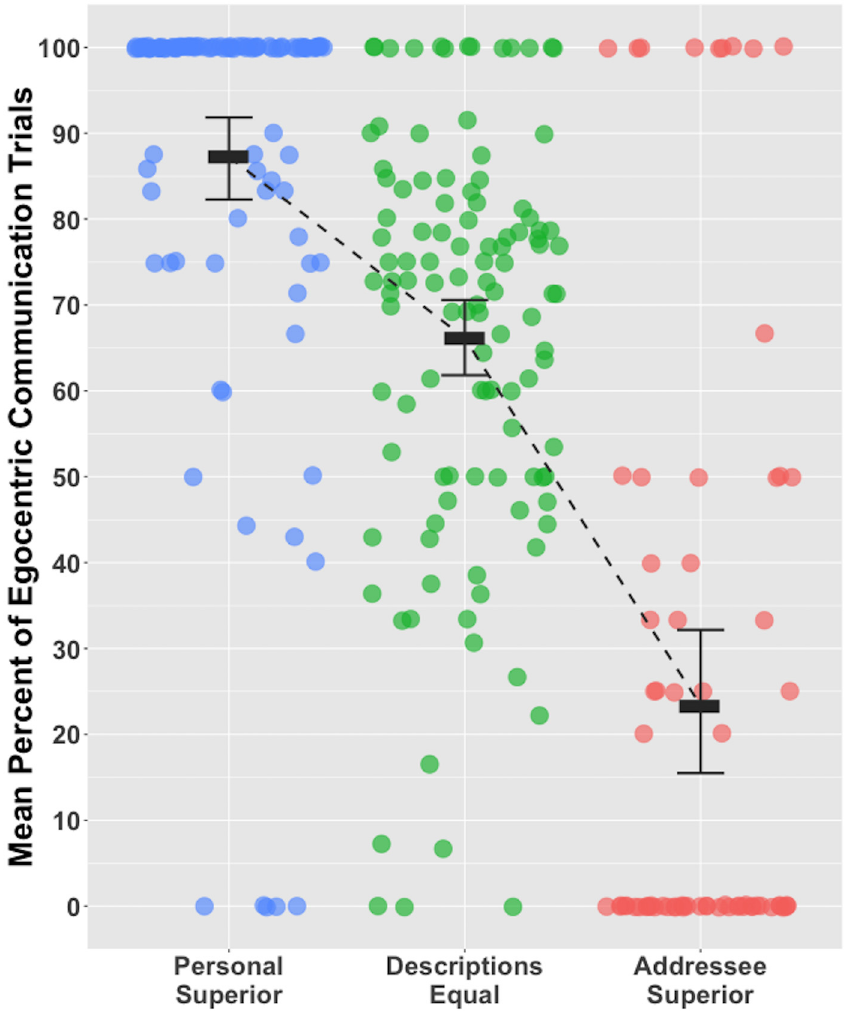
Fig 3. Mean percent egocentric communication by each participant when their personal shape descriptions were perceived to be more informative than their addressee ’ s shape descriptions (Personal Superior), when the shape descriptions were perceived to be equally informative (Descriptions Equal) and when the addressee ’ s shape descriptions were perceived to be more informative than their personal shape descriptions (Addressee Superior). Error bars are bootstrapped 95% confidence